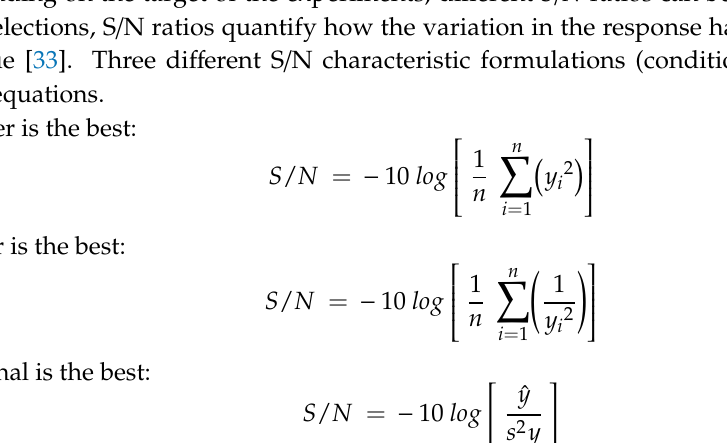
Figure 5. Block diagram of the system input and output factors.